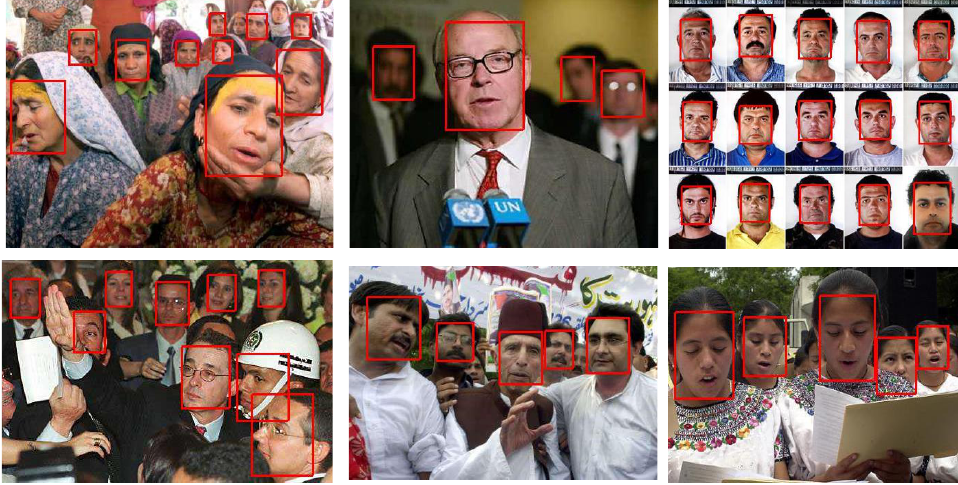
Figure 11. Visualization of the results of EagleEye on FDDB